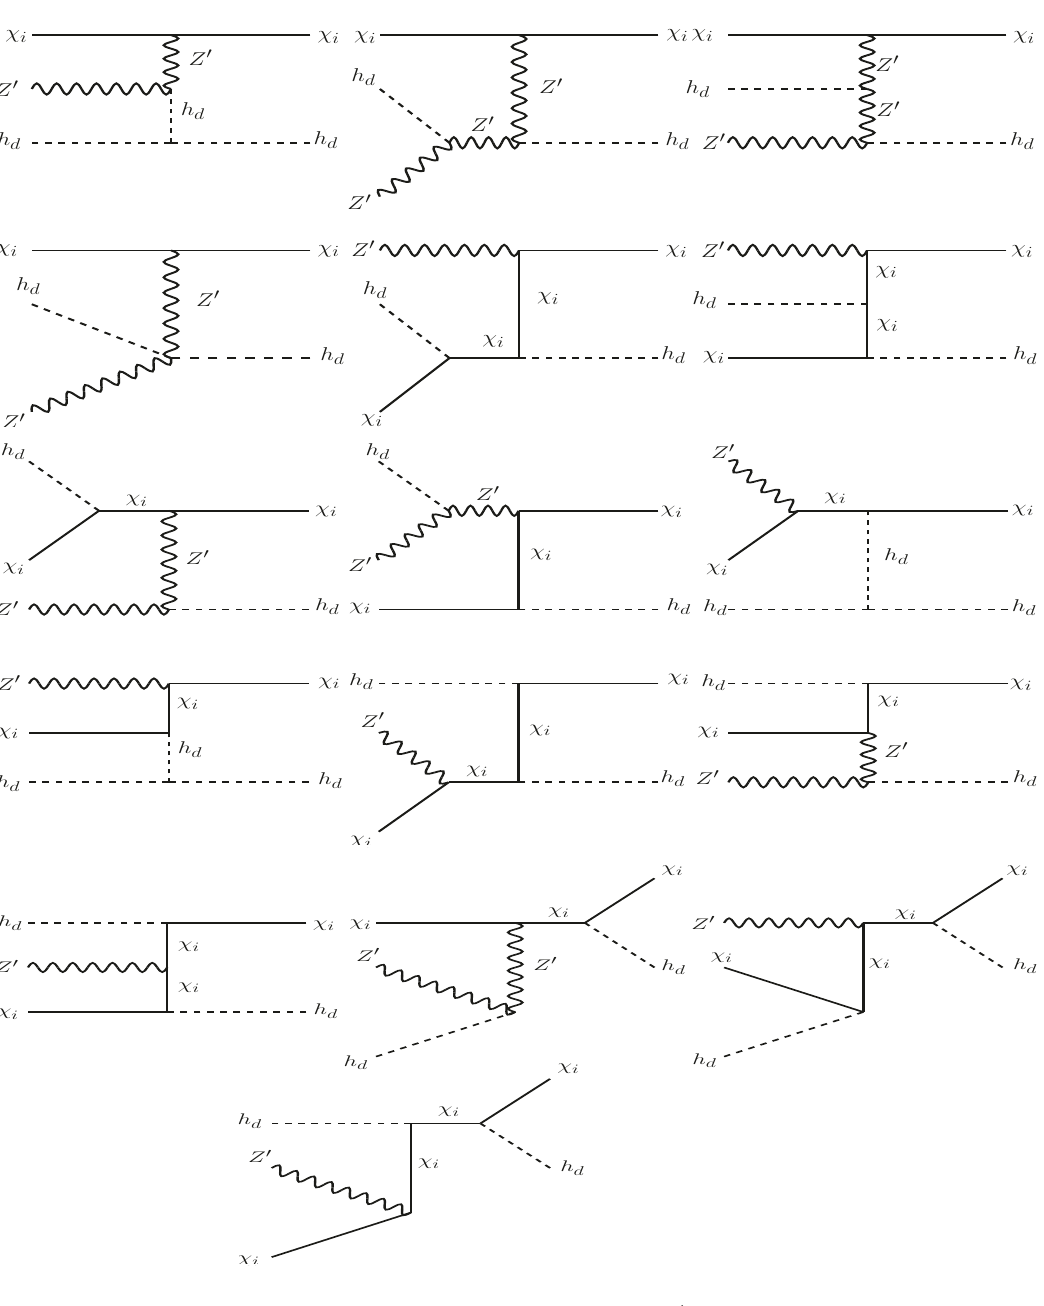
Z 0 h d → χ h d i i